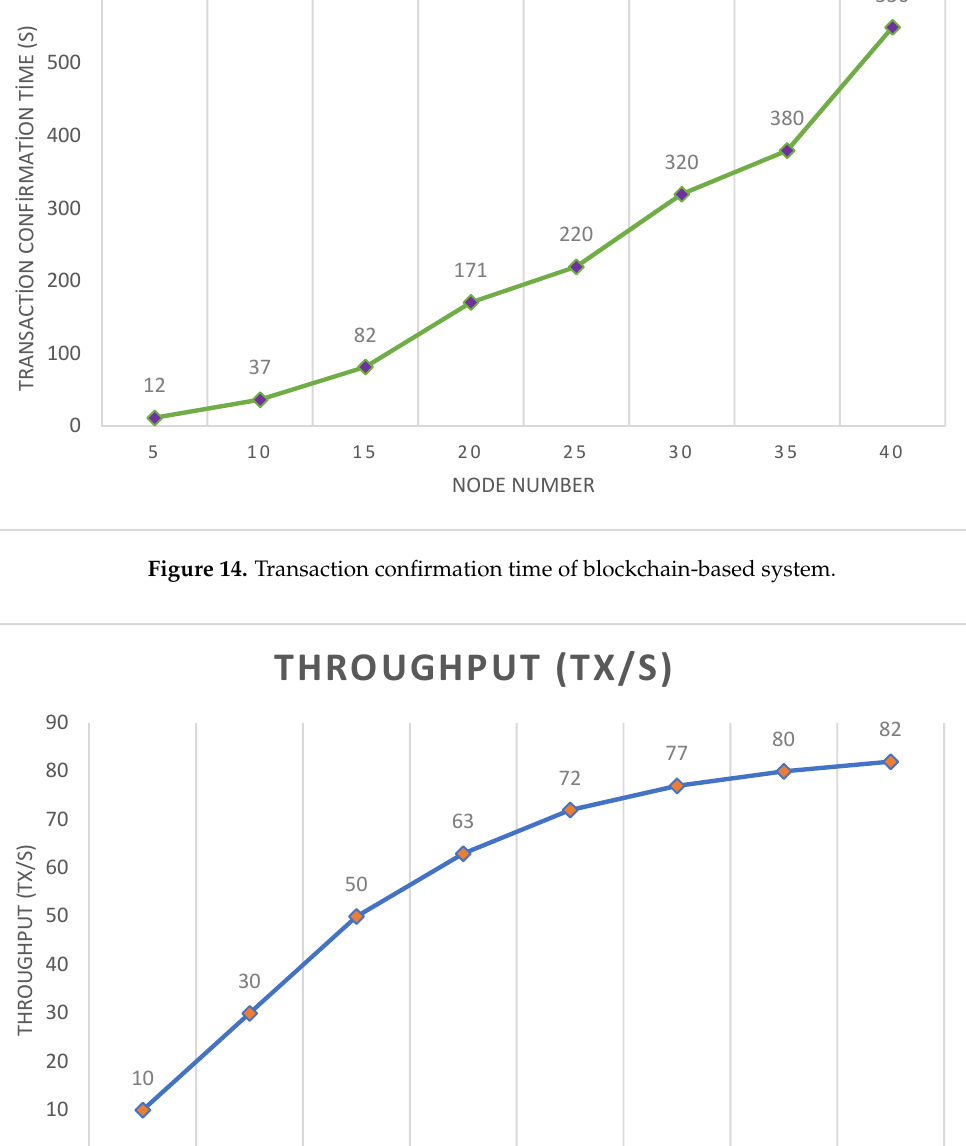
19 of 26 Figure 13. Benchmark of performance values graphs. After the differences and advantages of the established blockchain-based system, ac- cording to different infrastructures, were presented concretely, the second stage was started. In order to examine what kind of differences the blockchain layer provides, there are three main criteria in the literature that can be applied [26]: •